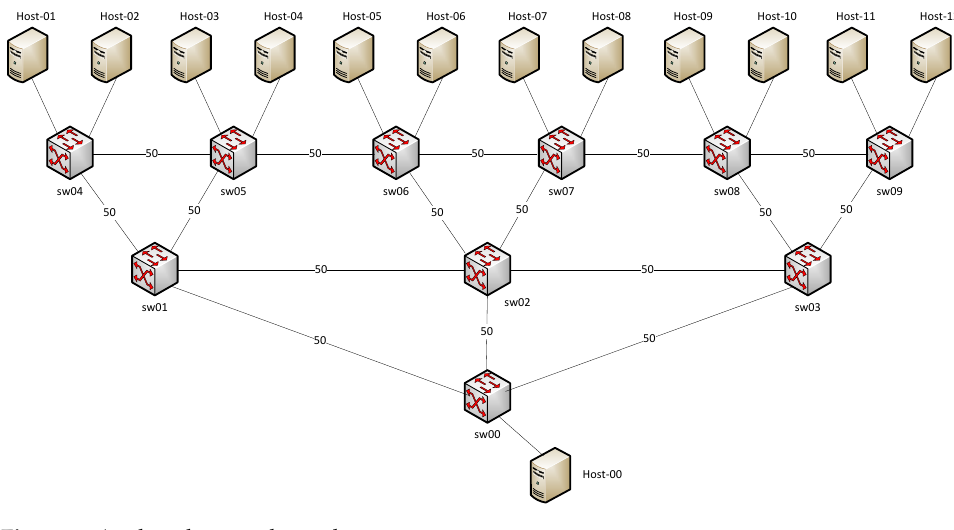
Figure 2. Analyzed network